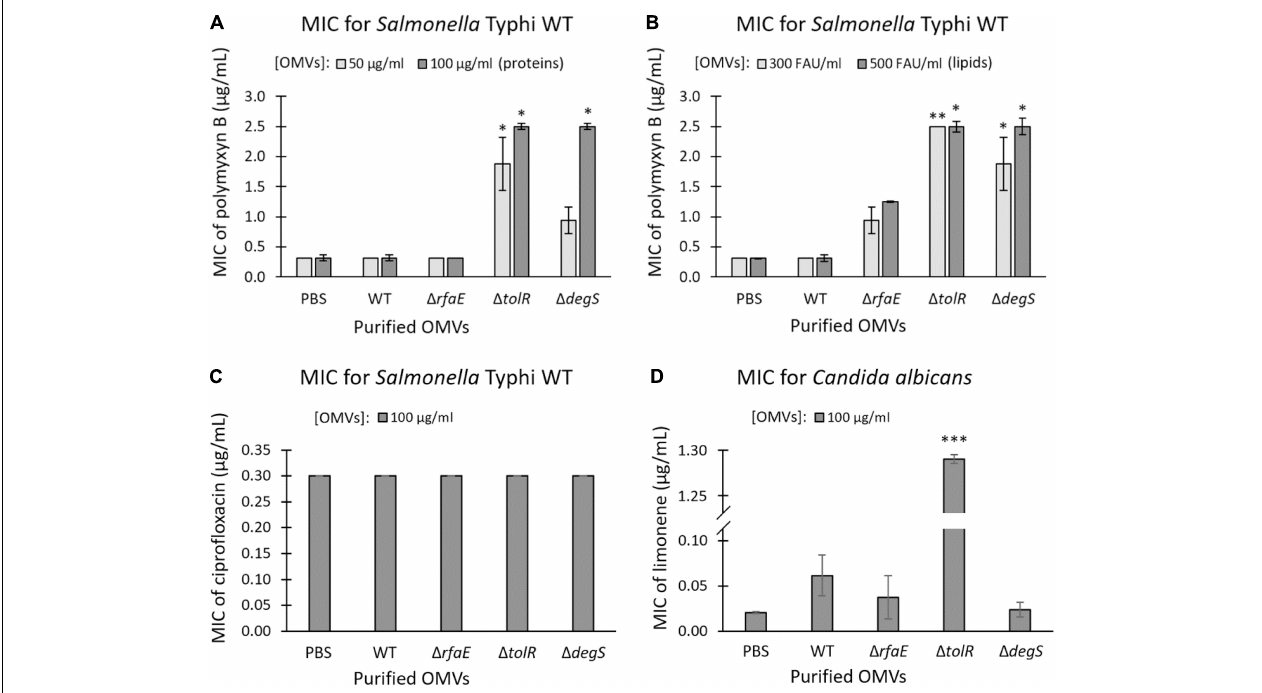
FIGURE 2 | Purified OMVs from S. Typhi mutant derivatives contributed to the resistance of polymyxin B and limonene. MIC of polymyxin B for S. Typhi WT supplemented with OMVs extracted from S. Typhi WT, (cid:49) rfaE , (cid:49) tolR, or (cid:49) degS (A,B) . OMV concentration was standardized as protein (A) or lipide content (B) and expressed as the final concentration. (C) MIC of ciprofloxacin for S. Typhi WT supplemented with OMVs extracted from S. Typhi WT, (cid:49) rfaE , (cid:49) tolR, or (cid:49) degS . OMVs were standardized by protein content. (D) MIC of limonene for a clinical isolate of Candida albicans supplemented with OMVs extracted from S. Typhi WT, (cid:49) rfaE , (cid:49) tolR, or (cid:49) degS . OMVs were standardized by protein content. In all cases, PBS was used as the negative control. FAU: Fluorescent arbitrary units obtained with the FM4-64 probe (Nevermann et al., 2019) as a measure of lipid concentration. ( n = at least 4; bars represent the standard error; One-way ANOVA, Tukey as a post hoc test, ∗ p < 0.05; ∗∗ p < 0.01; ∗∗∗ p < 0.001; compared with